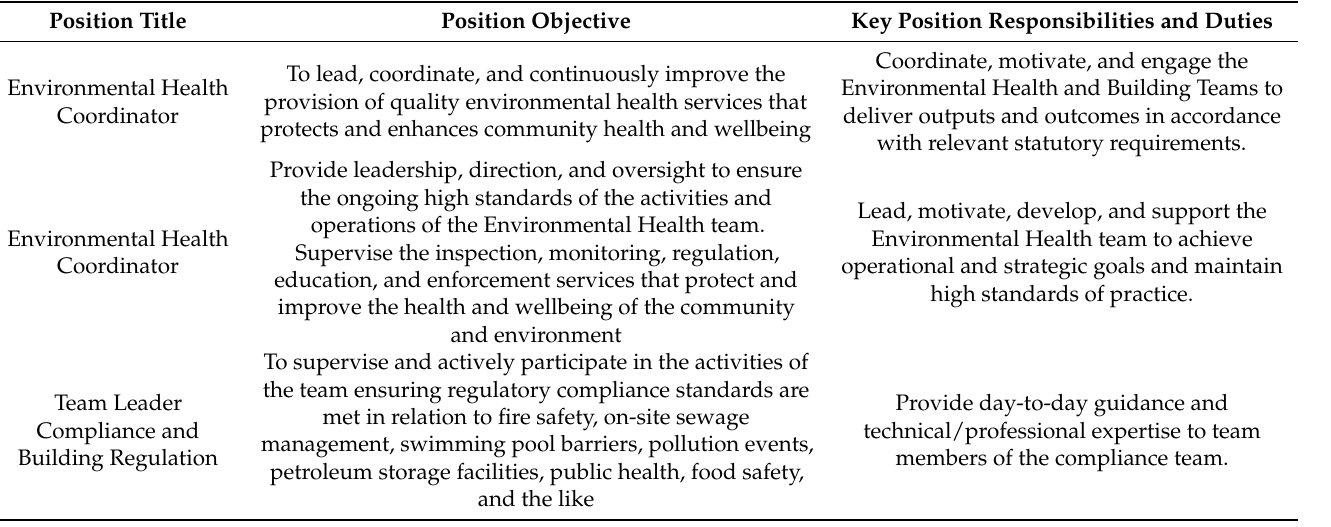
Table 4. Position objectives of advertised senior environmental health